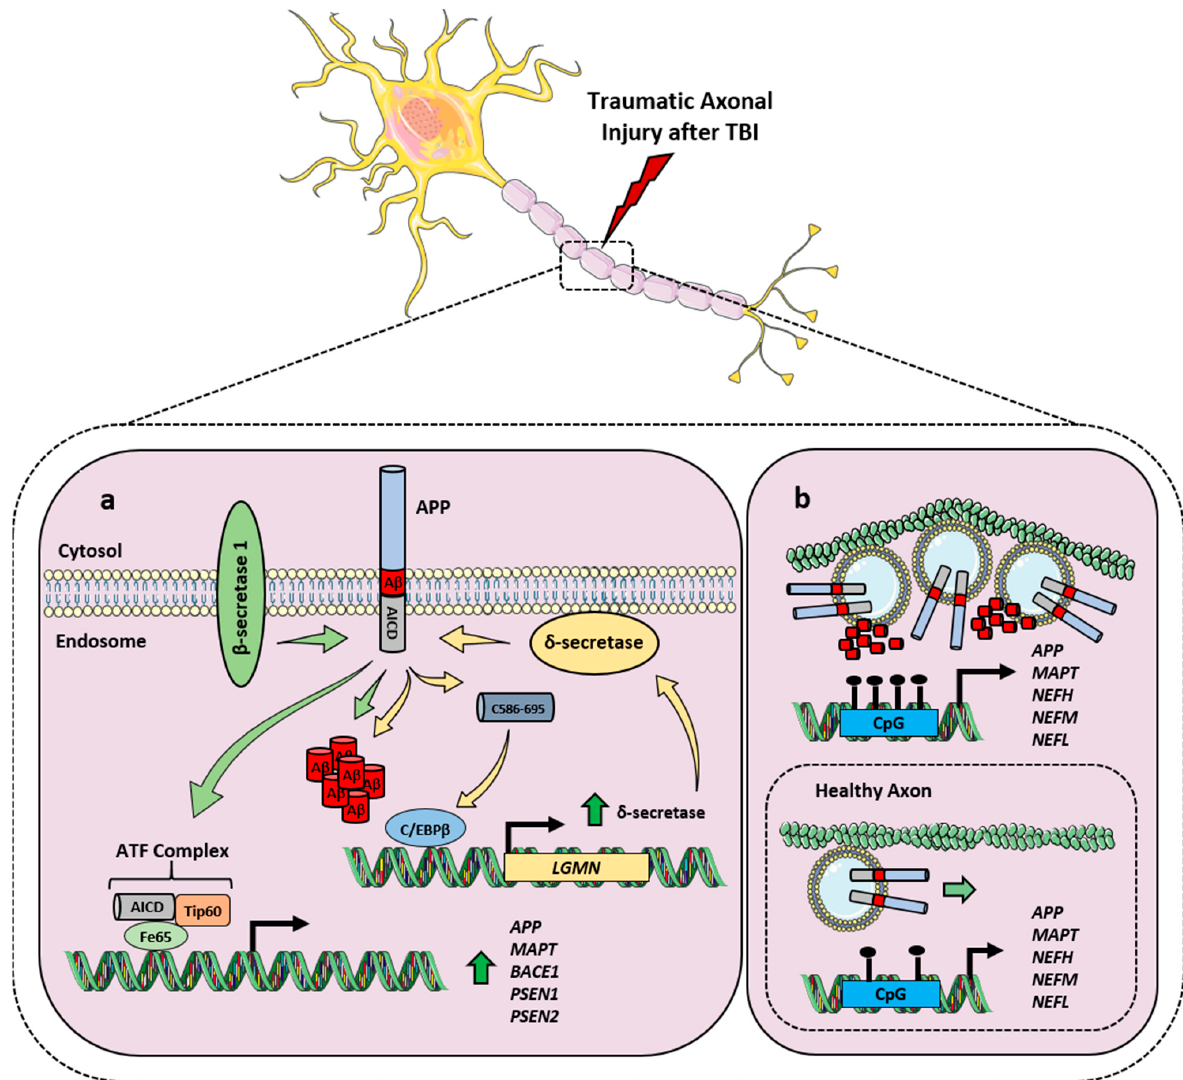
Figure 3. Alteration of APP processing after TBI. ( a ) Acute axonal damage after TBI induces the expression of APP, β -secretase 1 and γ -secretase components PS1 and PS2 ( dark green arrow ), as well as an increased A β generation and deposition. In addition, TBI triggers C/EBP β activation, which induces the expression of δ -secretase ( dark green arrow ) that, in turn, cleaves APP forming A β and the C586–695 peptide that activates C/EBP β . This suggests the establishment of a deleterious vicious loop possibly correlated to AD development. ( b ) Epigenetic and mechanical components of TBI-triggered APP processing alterations. After TBI, a di ff erential CpG methylation of APP , MAPT , Neuro fi lament Heavy ( NEFH ), Neuro fi lament Medium ( NEFM ) and Neuro fi lament Light ( NEFL ) is observed [92]. Moreover, the induced axonal cytoskeleton distortion impairs the fast-axonal transport of APP ( light green arrow ), which accumulates in proximity of the axonal injury site, resulting in A β deposition.